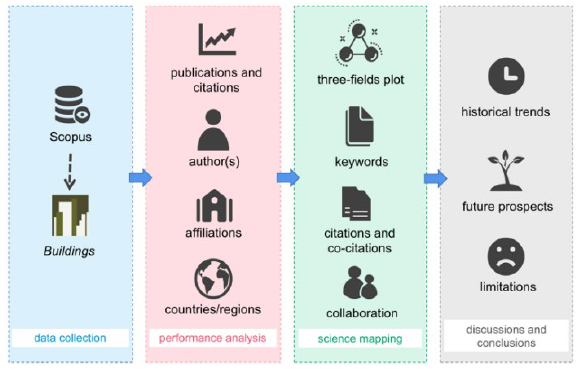
Figure 1. The process of bibliometric analysis.